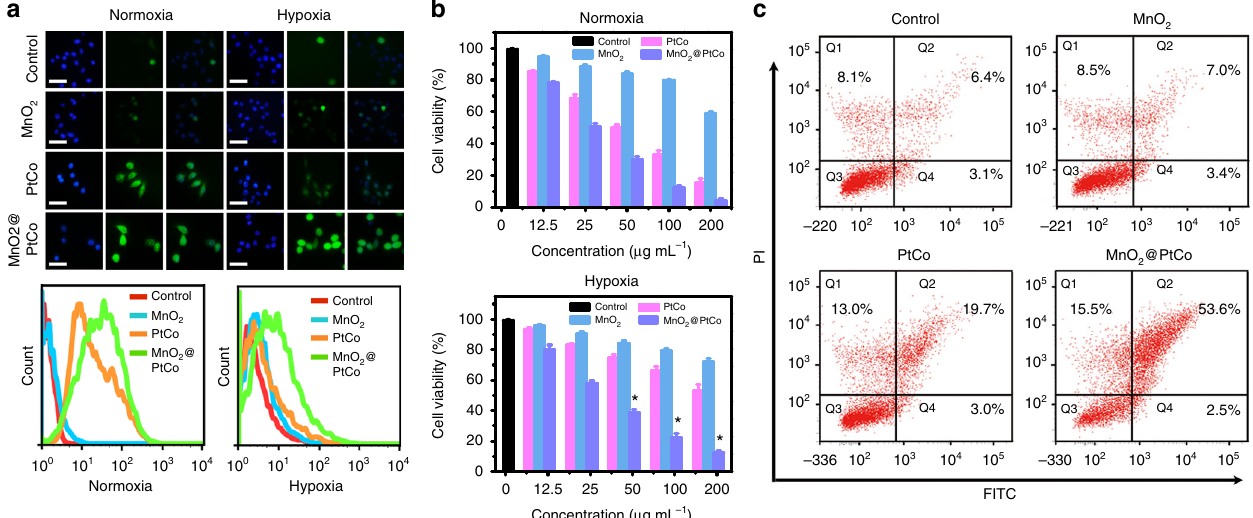
Fig. 4 In vitro assessments of MnO 2 @PtCo nano fl owers-induced intracellular oxidative damage. a Detection of MnO 2 @PtCo nano fl owers-induced ROS in 4T1 cells in normoxic and hypoxic culture media by fl uorescence microscopy and fl ow cytometry, respectively. The left, middle and right images show DAPI (blue), DCFH-DA (green) and the merged images, respectively. Scale bars are 50 μ m. b Cell viability of 4T1 cells treated with different concentrations of nanoparticles for 48 h in different O 2 tensions. Asterisks indicate signi fi cant differences ( * P < 0.01, ** P < 0.005, *** P < 0.001), analyzed by unpaired Student ’ s two-sided t test. Data were presented as mean ± s.d. ( n = 5). c Fluorescein-annexin V and PI staining assays of 4T1 cells treated with different